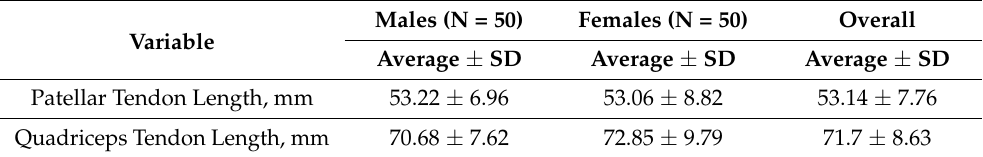
Table 3. Mean length of the patellar and the quadriceps tendon according to sex. SD, standard deviation. Males (N = 50) Females (N = 50) Overall Variable Average ± SD Average ± SD Average ± SD Patellar Tendon Length, mm 53.22 ± 6.96 Quadriceps Tendon Length,